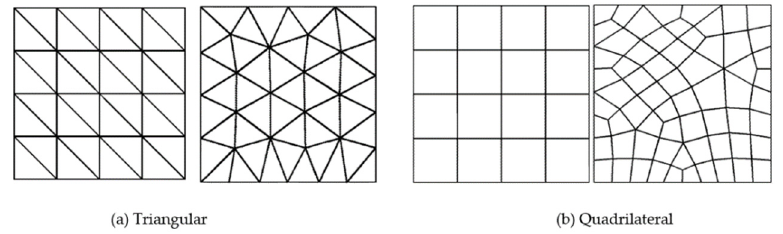
Figure 3. Regular/irregular subdivided element meshes for square plate domain. Table 1. Solution error and global effectivity for the plate problem using stress/displacement recovery and patch configu- ration (regular linear triangular element).